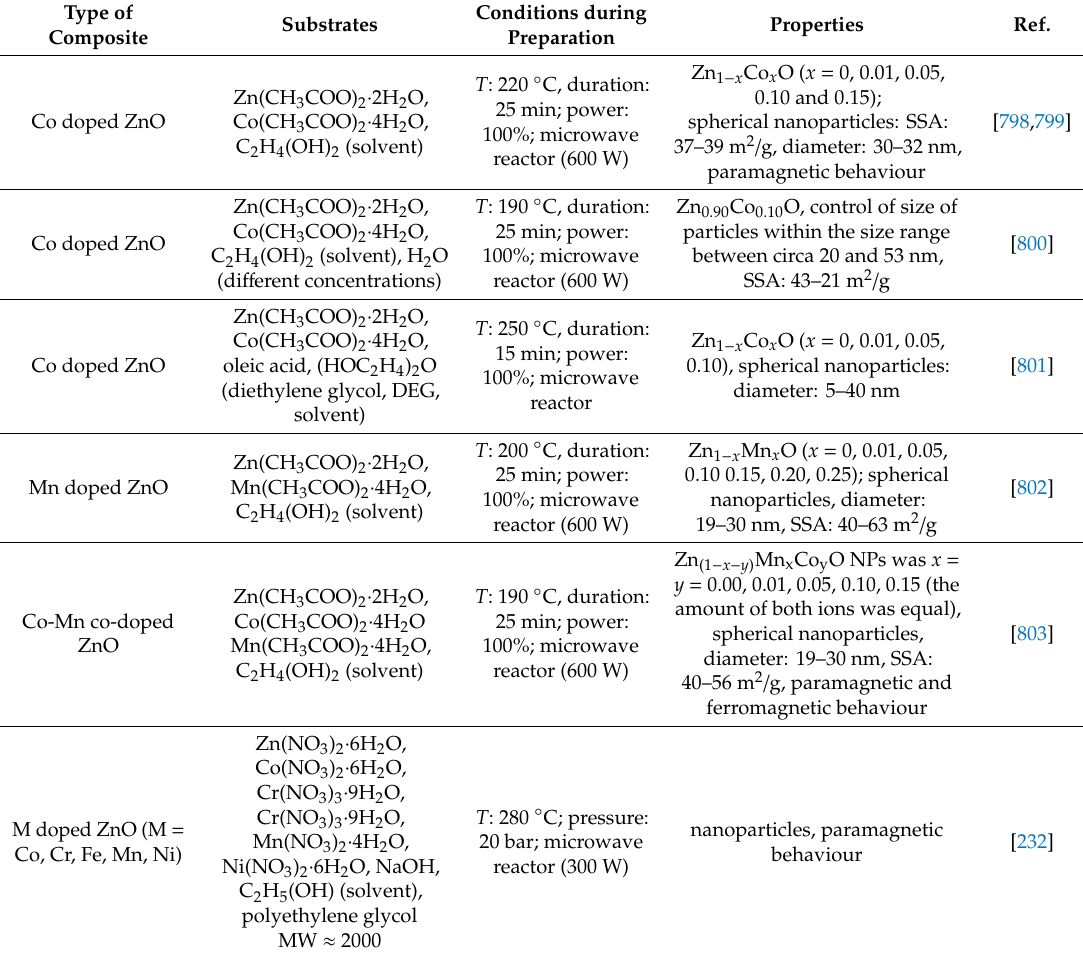
Table 11. Summary of the microwave solvothermal synthesis of ZnO nanocomposites or ZnO hybrid nanostructures without any additional heat treatment.